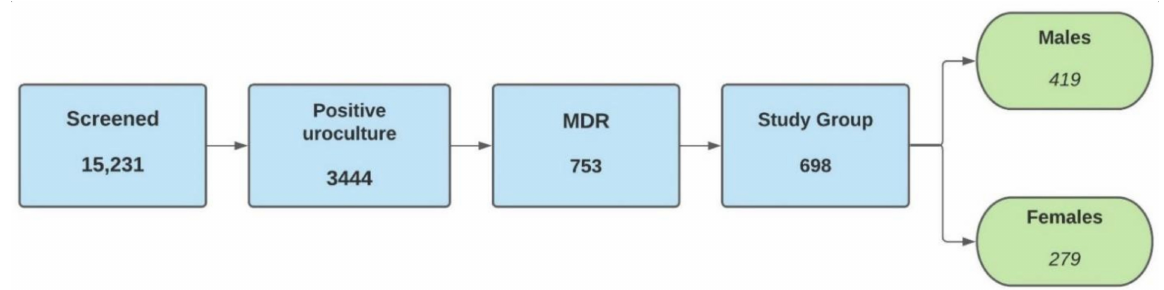
Figure 5. Diagram of the screened and enrolled patients in the study. Information on age, sex, and social–demographic status were registered for each patient; both hospitalized and ambulatory treated patients were considered for this study; thus, an exhaustive medical history for the second group was not